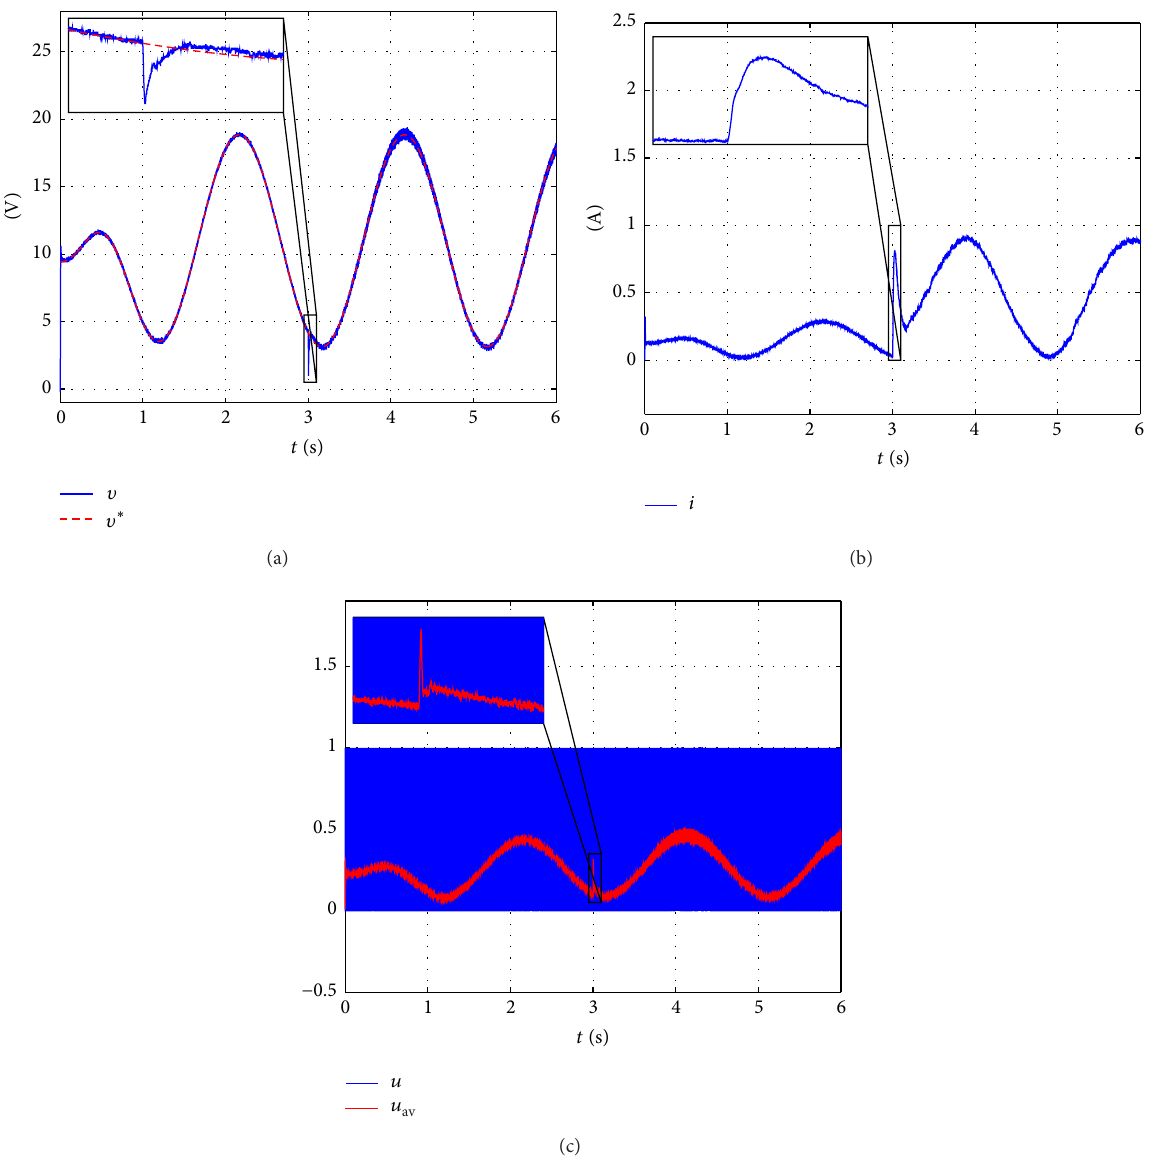
Figure 12: Case (iv) via Σ - Δ